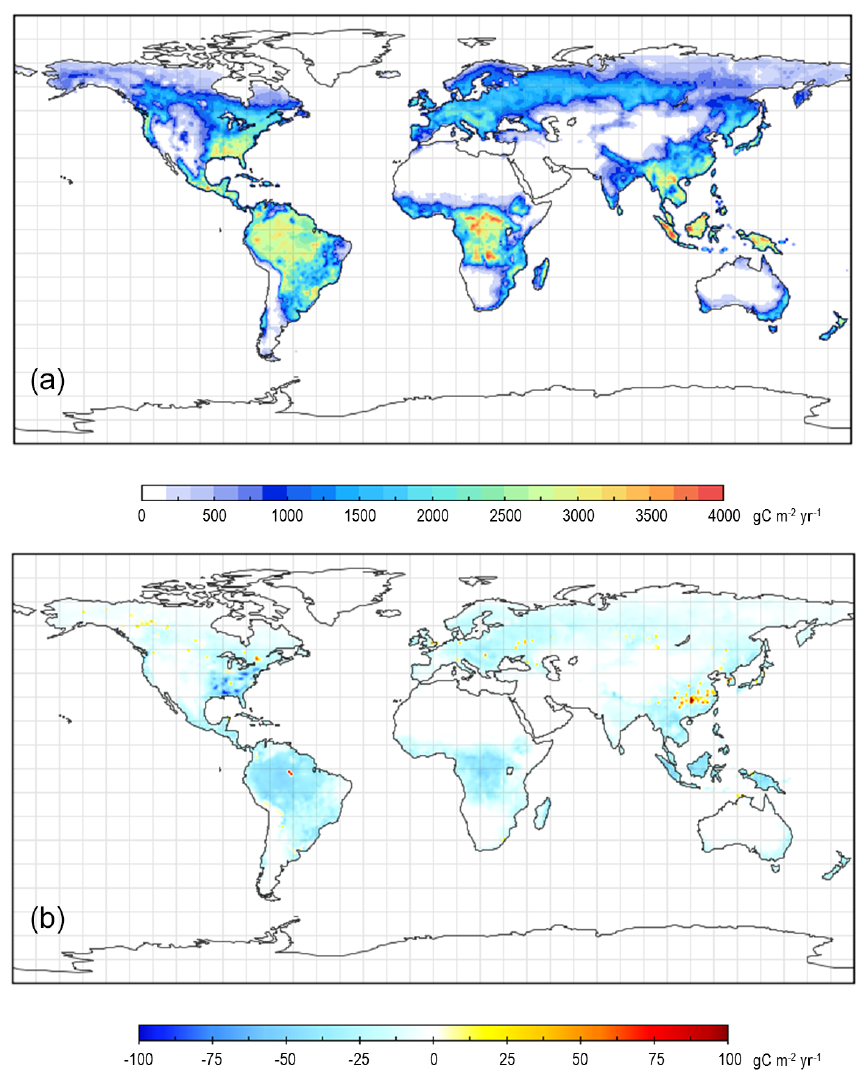
Figure 2. (a) Gross primary productivity (GPP) distribution in 2003 computed using remote sensing LAI and land cover maps and climate and soil data, and (b) net ecosystem productivity (NEP) distribution in 2003. Both are calculated using the BEPS model. Annual NEP maps from 2000 to 2004 are used to as the prior flux in the inversions. This GPP map is used to distribute the flux uncertainty among the 39 land